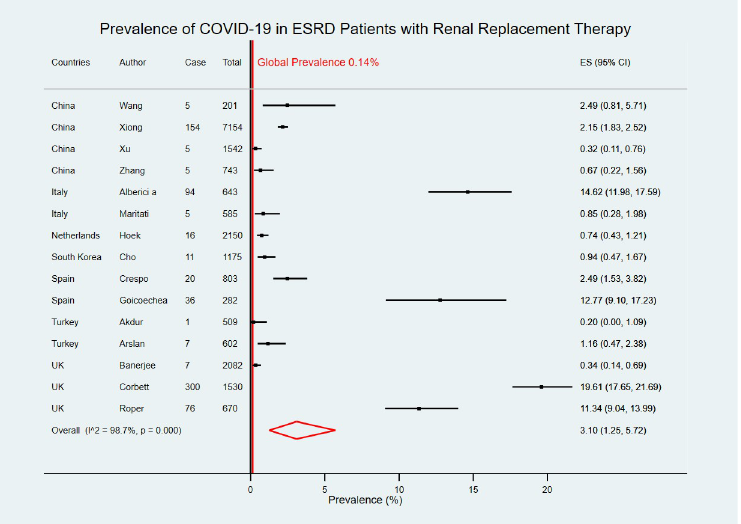
Fig 2. Forest plot of the prevalence of COVID-19 in ESRD patients with RRT. The figure summarizes the number of COVID-19 confirmed cases in end-stage renal disease (ESRD) patients with renal replacement therapy (RRT) and the total number of ESRD patients with RRT in 15 eligible studies. The forest plot represents the estimated prevalence of COVID-19 in ESRD patients with RRT for each study (black boxes), with 95% confidence intervals (95% CI; horizontal black lines). The estimated pooled prevalence (red diamond) was 3.10% (95% CI 1.25–5.72). The global average prevalence (vertical red line) was 0.14%. The meta-analysis used a random-effects model with the exact method for confidence interval estimation. ES, effect size. I 2 , test for